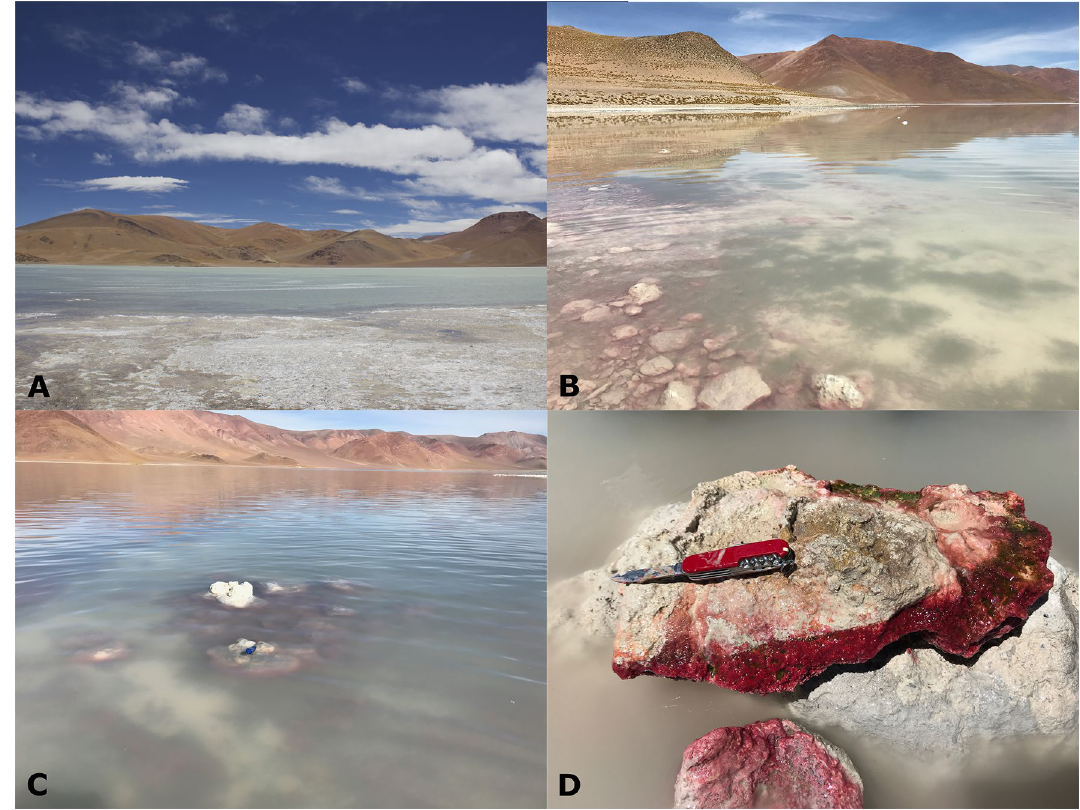
Figure 1. ( A ) Panoramic photography of the Diamante Lake, located in the Catamarca province, Argentina. (B-C) Submerged microbialites. ( D ) Red biofilms attached to gaylussite crystals at the bottom of the submerged